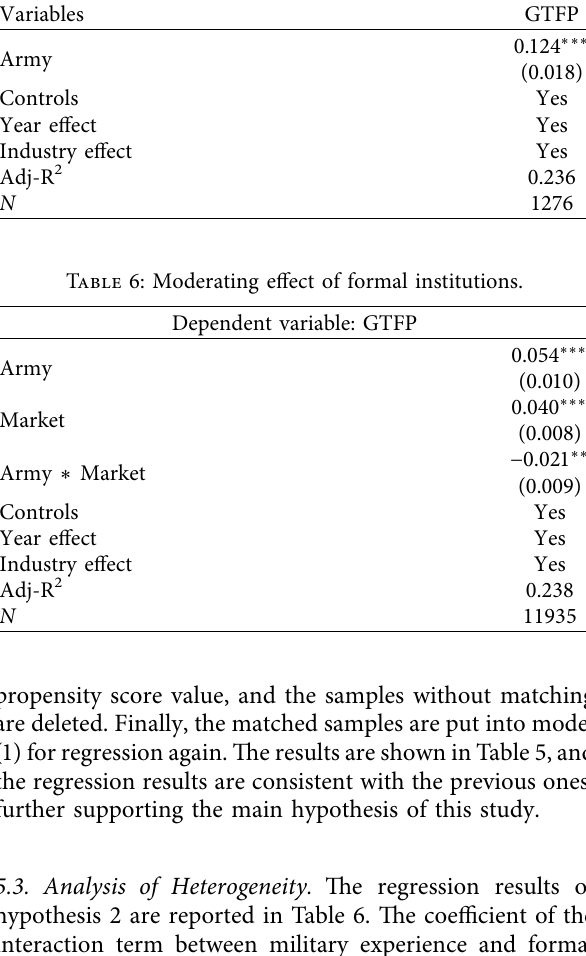
Table 3: Benchmark regression results.